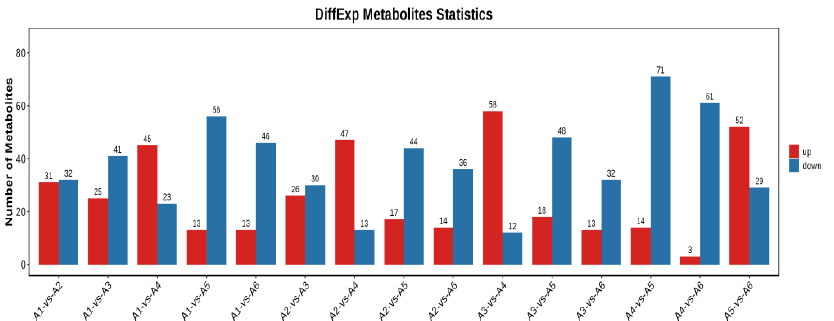
Figure 4. Statistical graph of the number of differential metabolites between varieties. The horizontal coordinates are for each comparison group, the vertical coordinates are for the number of differential metabolites in each comparison group, red represents the number of differential metabolites up-regulated in the latter relative to the former in the comparison group, and blue represents the number of differential metabolites down-regulated.